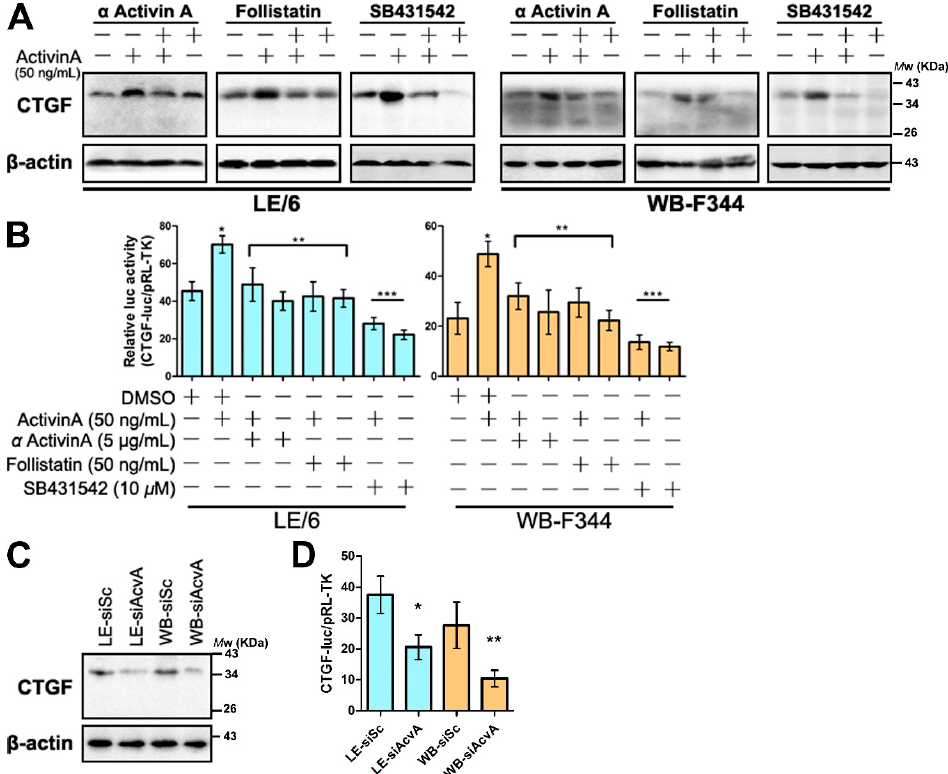
Figure 5. Activin A induced the production of CTGF/CCN2 in LPCs. ( A ) LE/6 or WB-F344 cells was treated with indicated cytokines and inhibitors for indicated times. Lysates were subjected to Western blot analyses to measure the expression of CTGF/CCN2. β -Actin was used as a loading control; ( B ) LE/6 or WB-F344 cells was co-transfected with pRL-TK and CTGF-luc plasmids and treated with indicated cytokines and inhibitors for 16 h. Luciferase activity was normalized to renilla luciferase activity and expressed as the means ˘ S.E.M. of triplicate measurements, * p < 0.01 compared with the first; ** p > 0.05 compared with the first and p < 0.05 compared with the second; *** p > 0.05 compared with the first and p < 0.01 compared with the second; ( C ) Lysates of LE-siSc/LE-siAcvA cells and WB-siSc/WB-siAcvA cells were subjected to Western blot analyses to measure the expression of CTGF/CCN2. β -Actin was used as a loading control; ( D ) LE-siSc /LE-siAcvA or WB-siSc/WB-siAcvA cells were co-transfected with pRL-TK and CTGF-luc. Luciferase activity was normalized to renilla luciferase activity and expressed as the means ˘ S.E.M. of triplicate measurements. * p < 0.05; and ** p < 0.01, compared with their control group (siSc),